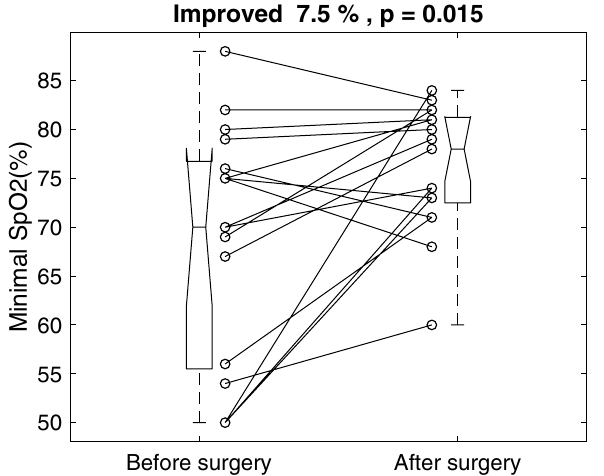
Figure 3. Individual minimal oxyhemoglobin saturation of pulse oximetry (SpO2) before and after the surgery.